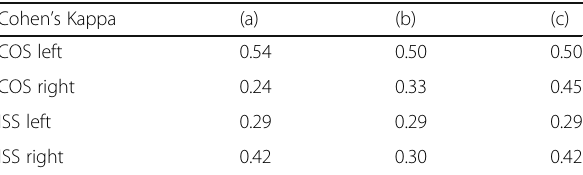
Table 2 Cohen ’ s Kappa values showed a low correlation for the categorial measurement values between the radiographs of (a) positioning I, (b) positioning II, (c) positioning III and the corresponding CT scans (COS: cross-over sign, ISS: ischial spine